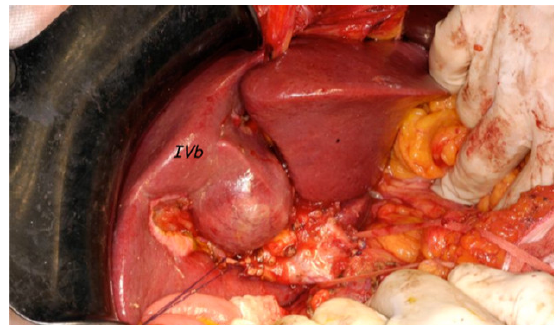
Figure 3. Intraoperative image of one IFN-treated patient. The HCC lesion in a noncirrhotic liver can be observed in segment IV.